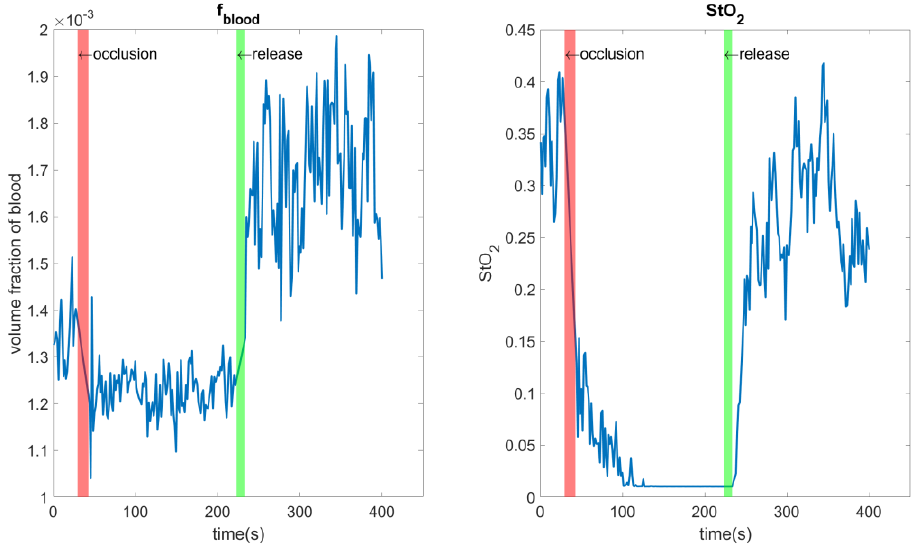
Figure 6. Extracted f blood and StO 2 during the arterial occlusion experiment.